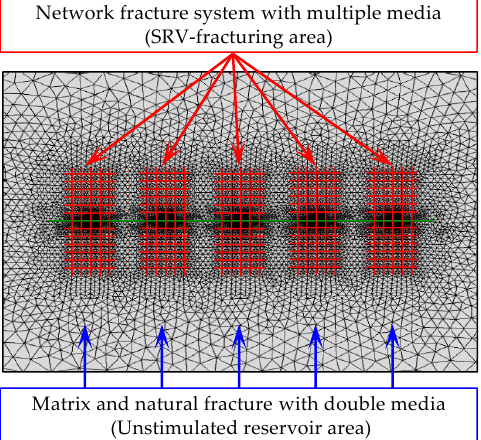
Figure 2. 3D gridding division near an SRV-fractured horizontal well area.